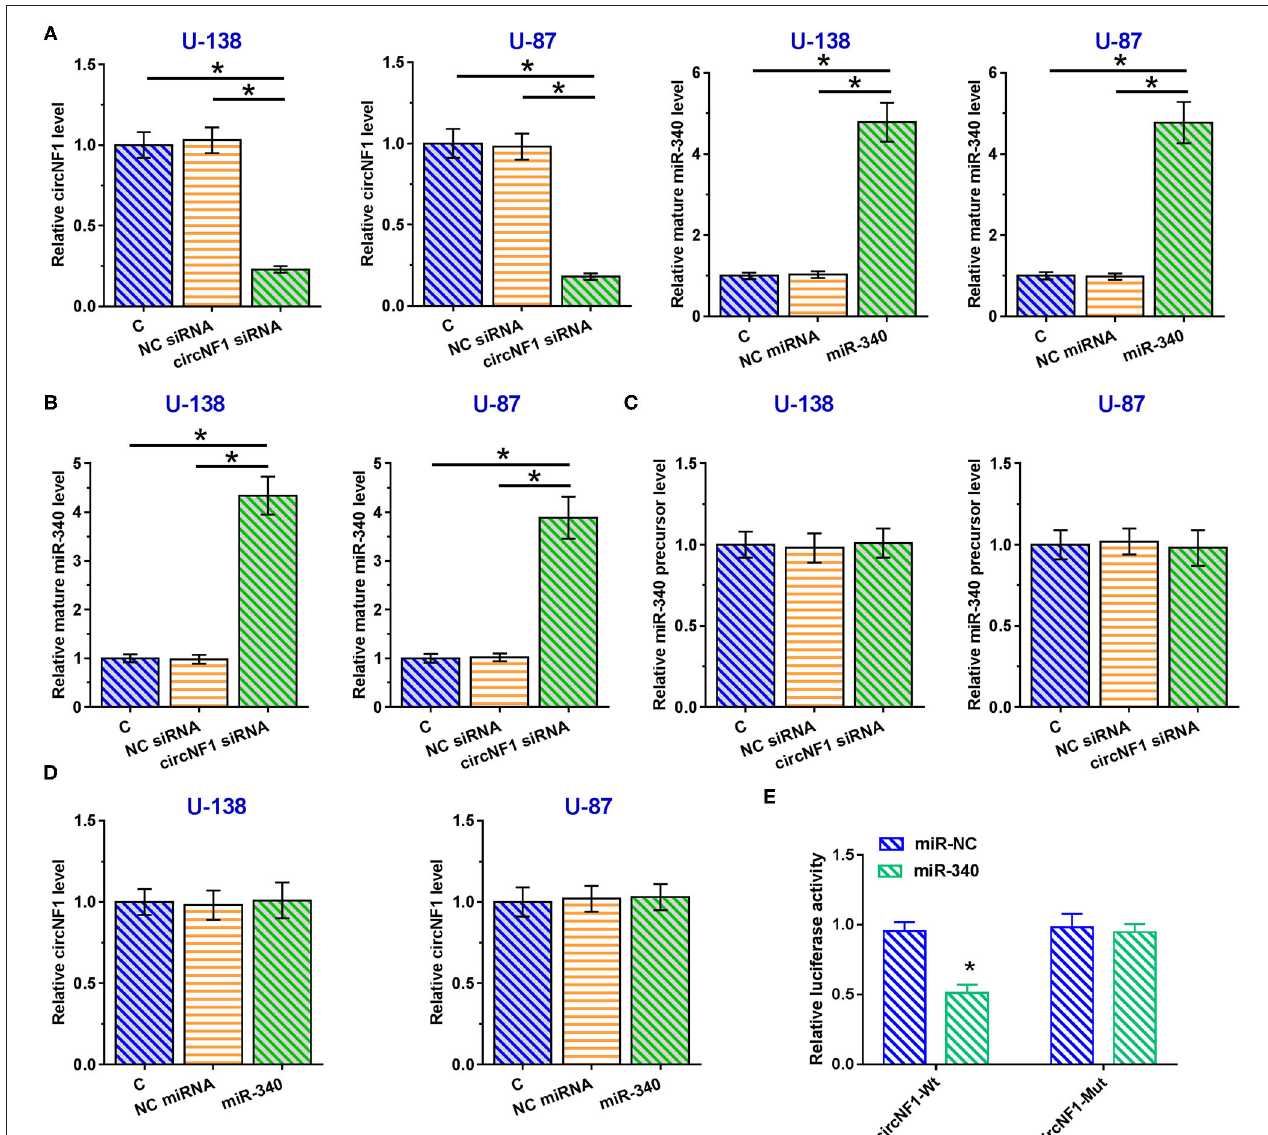
FIGURE 4 | circNF1 siRNA silencing promoted the maturation of miR-340 in glioblastoma (GBM) cells. (A) U-138 and U-87 cells were transfected with either circNF1 siRNA or miR-340 mimic, and transfection was confirmed by RT-qPCR. The effects of circNF1 siRNA silencing on (B) mature miR-340 and (C) miR-340 precursor were explored by RT-qPCR. (D) The effects of miR-340 overexpression on circNF1 expression were also explored by RT-qPCR. (E) A luciferase reporter gene assay was conducted to determine the interaction between circNF1 and miR-340. Data from cell transfection experiments were expressed as mean ± SD values of three biological replicates, and data comparisons were performed by ANOVA Tukey’s test. * p <